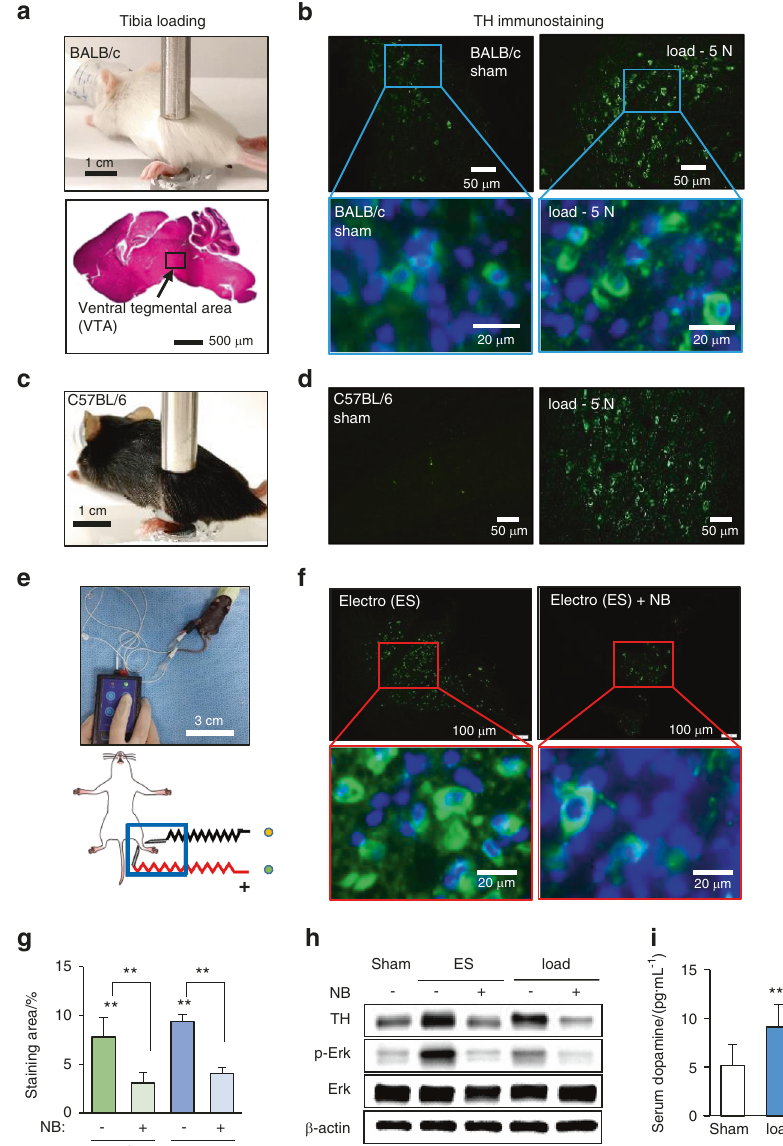
Fig. 1 Elevation of tyrosine hydroxylase and dopamine by tibial loading. TH tyrosine hydroxylase, load tibial loading, ES electrostimulation, NB nerve block. The single and double asterisks indicate P < 0.05 and 0.01, respectively. a Setup for tibial loading with a BALB/c mouse. The ventral tegmental area (VTA) is shown in the sagittal section of a mouse brain. b Elevation of TH immunostaining in the VTA in the sagittal section of the loaded sample. c , d Load-driven elevation of TH in the VTA of C57BL/6 mice. e , f Elevation of TH induced by electrostimulation, and TH level suppression by local administration of lidocaine, a nerve block agent. g TH-immunostained area (in %) in the VTA induced by electrostimulation (ES) and tibial loading (load) showing that the application of a nerve block (NB) reduced the stained area. h Elevation of TH, p-Erk, and p-p38 in the brain induced by electrostimulation and tibial loading. The elevation of these factors was suppressed by the nerve block agent. i Elevation of dopamine in the serum by tibial loading. The serum was harvested 1 h after tibial MMP9, and Runx2 (Fig. 6d). These results support the notion that which links loading-driven regulation of the dopamine-Lrp5 axis CCN4 is a dopamine/Lrp5-responsive downstream regulator that is to tumor-promoting genes such as Snail, MMP9, and Runx2. Since downregulated in the serum by mechanical loading. mechanical loading elevated the serum level of dopamine, a Immunohistochemical analysis indicated the elevation of the protein array analysis including 111 cytokines and proteins DRD1 level in the brain of the loading group and the DRD2 level in isolated from the serum was performed. Among four loading- the loading and FP groups, while the reduction of the levels of responsive candidates (CXCL13, IL12, endostatin, and CCN4) CCN4 and Lrp5 in these two groups was detected (Supplementary (Fig. 6a), we selected CCN4, which is known as an oncogene Fig. 4a). The Western blotting results using the protein samples inducible by Wnt signaling. 24 A Western blot analysis with 4T1Br isolated from the tumor-invaded brains were consistent with the cells revealed that CCN4 was downregulated by dopamine and FP immunohistochemical results (Supplementary Fig. 4b). We also in a dose-dependent fashion (Fig. 6b). Furthermore, CCN4 was detected the expression levels of DRD1 in four cell lines (4T1Br, decreased in Lrp5 siRNA-treated 4T1Br cells (Fig. 6c), and 4T1.2, MDA-MB-231, and EO771 mammary tumor cells). incubation with recombinant CCN4 proteins elevated Snail,